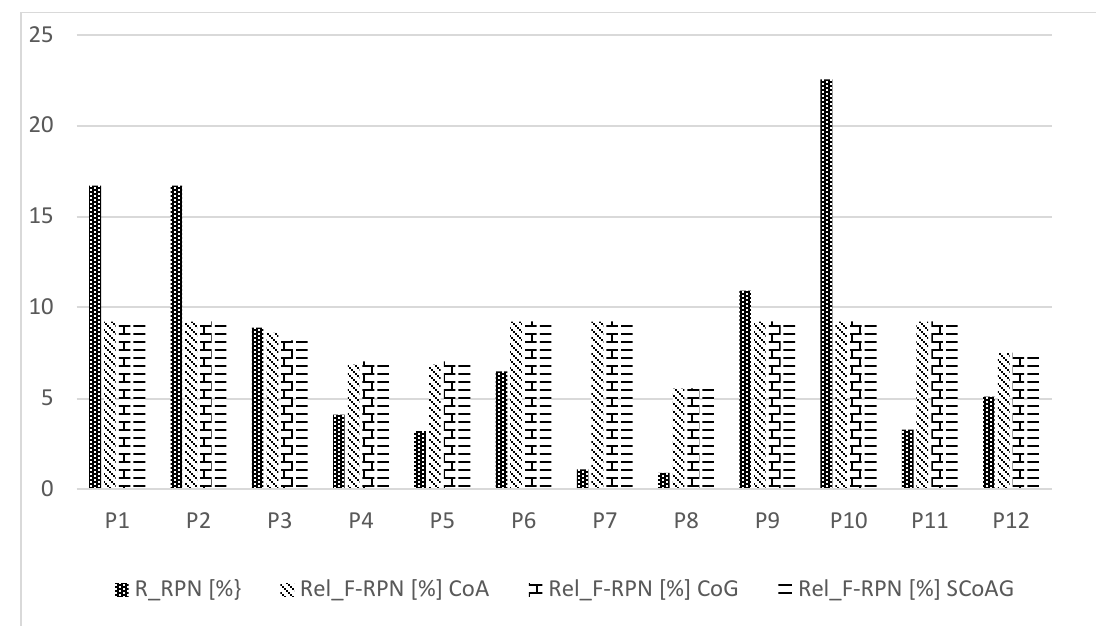
Figure 11. Effect of the methods .